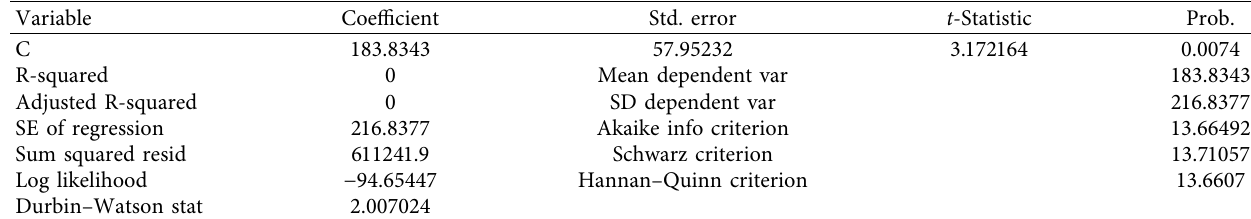
Figure 10: Autocorrelation and partial correlation diagram of first-order difference series of residential expected sales area. Table 7: Estimated results of ARIMA model for expected residential sales area.